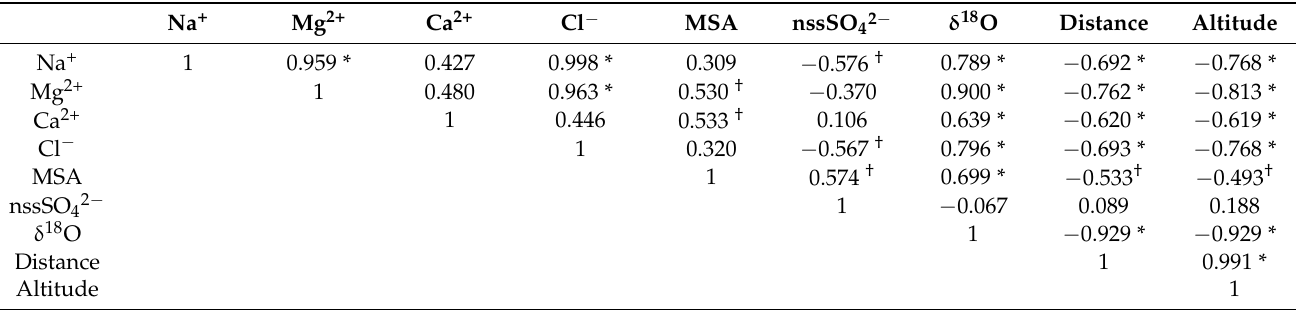
Table 4. Correlation matrix of the major ions and δ 18 O values of surface snow samples along with distance from the coast and